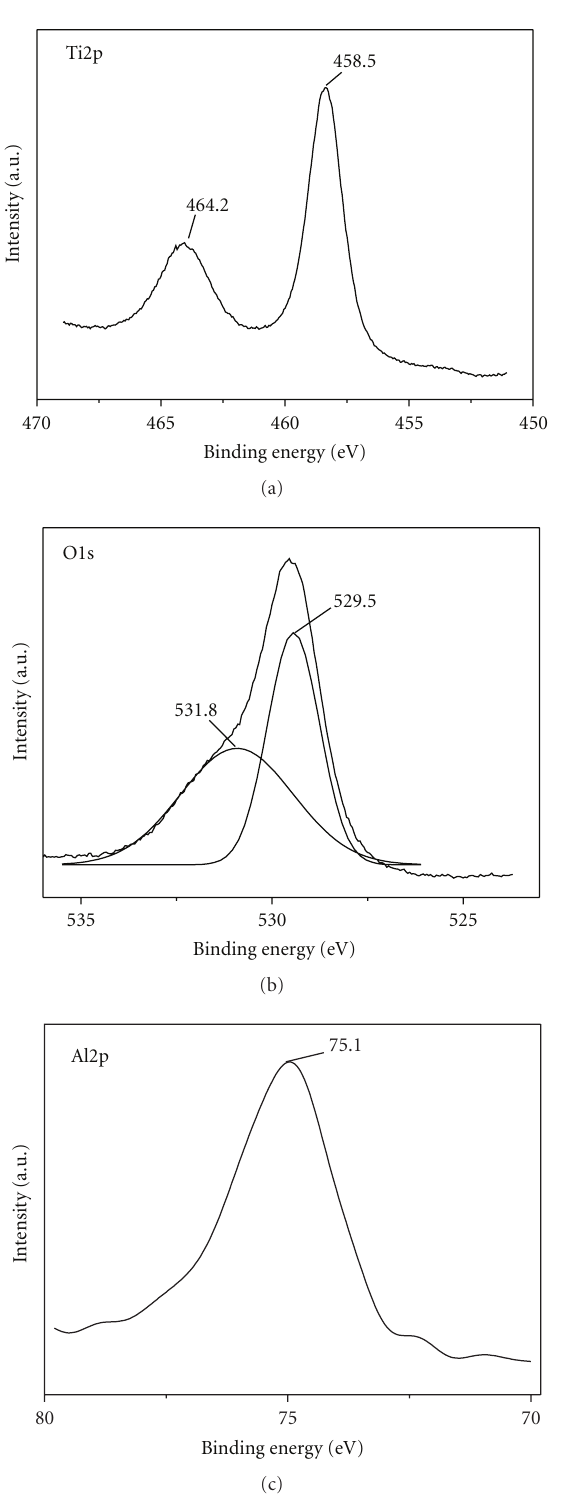
Figure 4: XPS spectra of mesoporous TiO 2 -Al 2 O 3 binary oxides prepared at C PEG1000 = 0.030 mol/L.